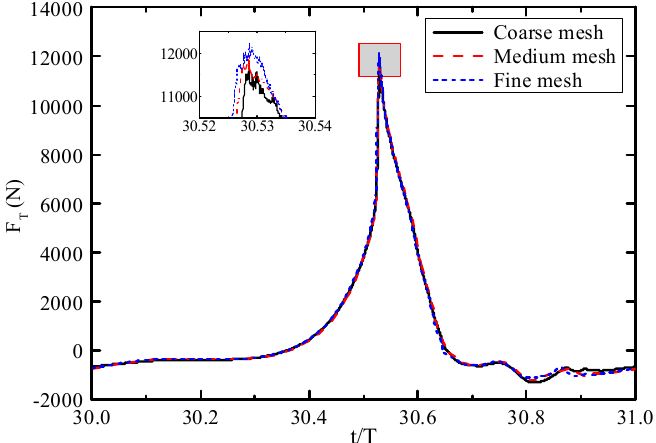
Figure 2. Grid refinement study for the breaking wave forces on the vertical cylinder.